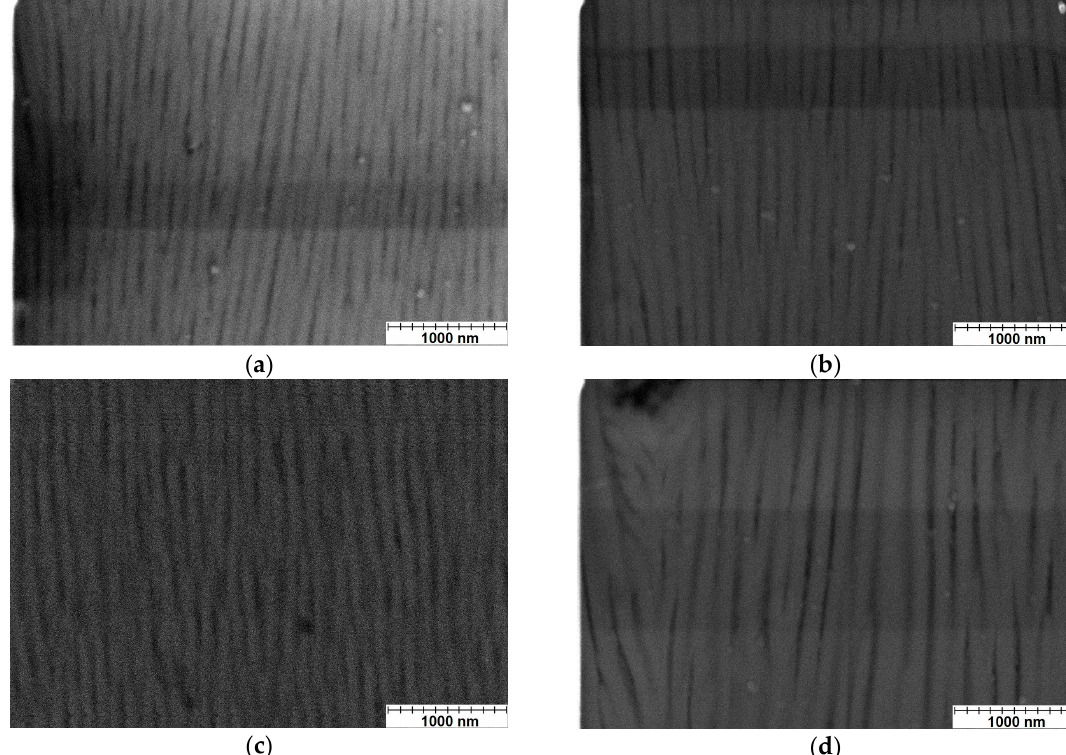
Figure 1. SEM micrograph (cross-section) of nanostructure of the coatings: ( a ) Sample A, ( b ) Sample B, ( c ) Sample C, ( d ) Sample D (sample designations as in Table 2).